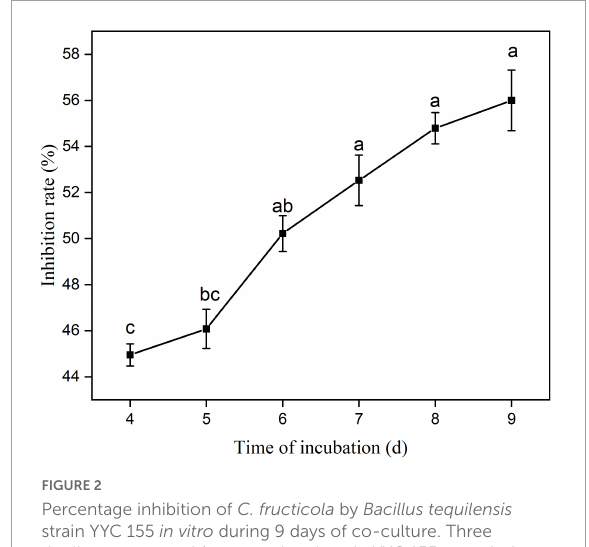
FIGURE2 Percentage inhibition of C. fructicola by Bacillus tequilensis strain YYC 155 in vitro during 9 days of co-culture. Three duplicates are used for control and strain YYC 155 at each time point. Data represent the mean ± standard error (se). Different letters indicate a significant difference between the inhibitor rate on different days as determined by Duncan’s multiple range tests ( P <